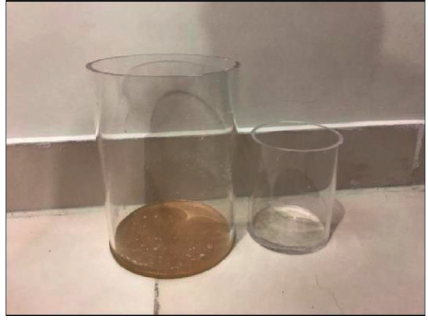
Figure 9: Cylindrical Plexiglas containers